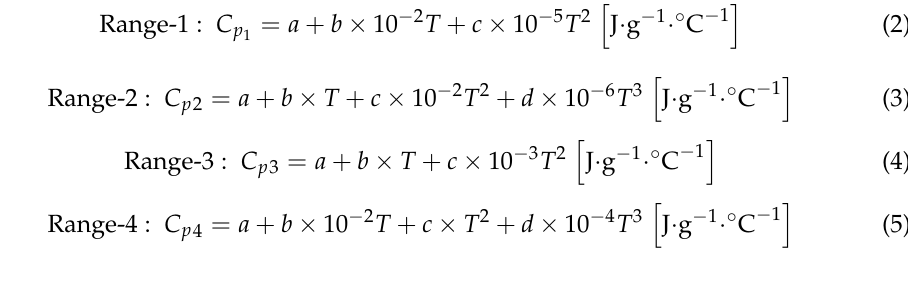
Figure 4. Change in the peaks’ temperature in the crystallization region of the BF slag with different contents of MgO.